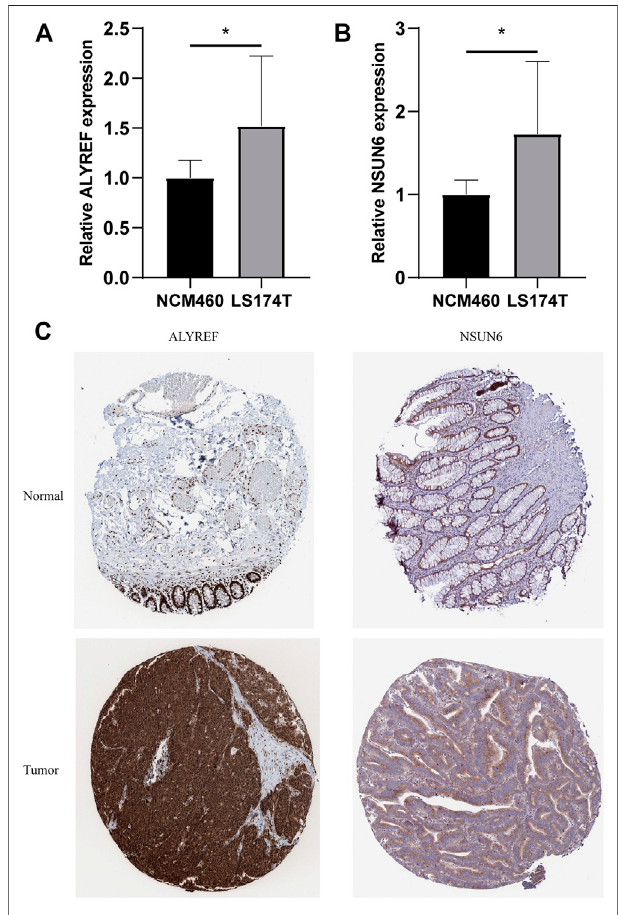
FIGURE 11 | Validation of the Expression Levels of the m 5 C-Related Regulators in Cell Lines and Clinical Samples. (A,B) Expression of ALYREF and NSUN6 in COAD cell lines LS174T and normal colon mucosal epithelial cell line NCM460. * p < 0.01. (C) IHC analysis of the protein level expression ofALYREF andNSUN6inCOADand normaltissues inHPA online